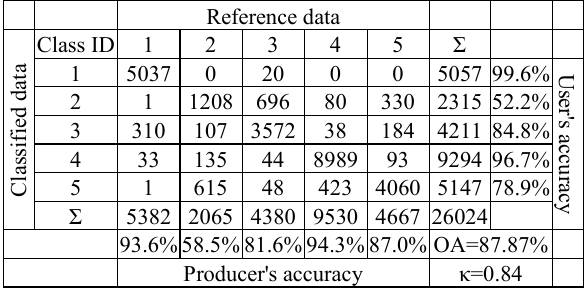
Table 4. Confusion matrix for land-cover classification based on the fused